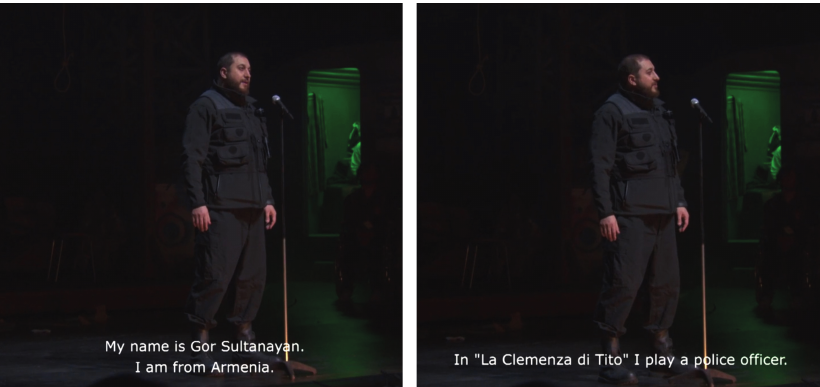
Figg. 3 and 4 At the beginning of act II, the actor Gor Sultanyan, interpreting the leader of Tito’s militia, introduces himself and his son as descendants of a survivor from the 1915 Armenian Genocide. When he had to “kill” his son at the end of act I (at this point, he stops in a moment of commotion), he says he just did it, like he would have done any other scene. The son crosses the stage and Gor holds out a hand to reach him, but the kid falls dead on the floor. Mozart’s Fantasia in C minor K.475 stops, Gor comes back to the mic, and says: “This for me was the moment I understood my son’s talent.” He then proceeds with the hanging of the rebels, and the “opera” is restored. Still frame from the streamed performance on GTG Digital (February 19,